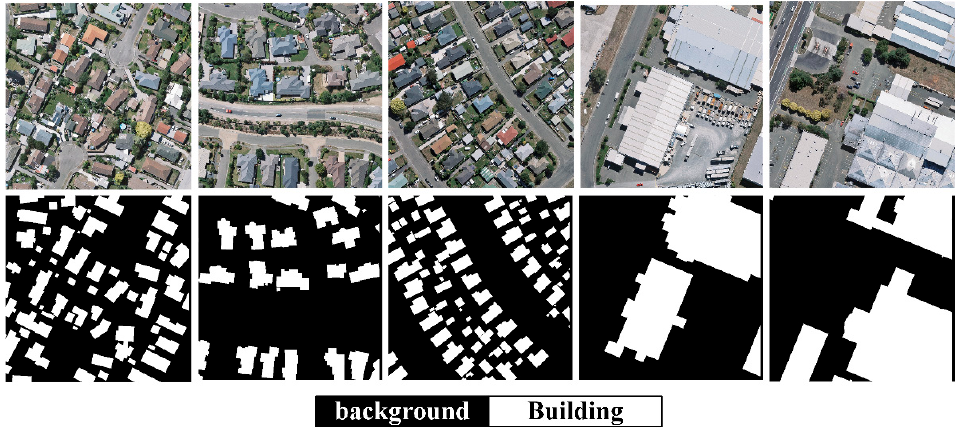
Figure 7. Some typical sample images of WHU building dataset and their corresponding labels.